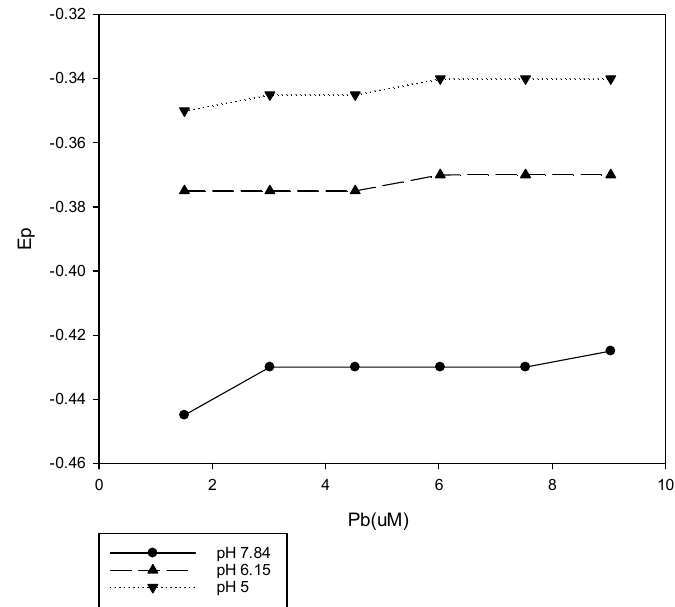
Figure 1. Differential pulse polarography (DPP) results for the reduction of Pb 2+ in the presence of 1.25 mM 3,4-dihydroxybenzoic acid at three different pH values. The peak maximum (E p ) becomes increasingly negative as the pH increases.